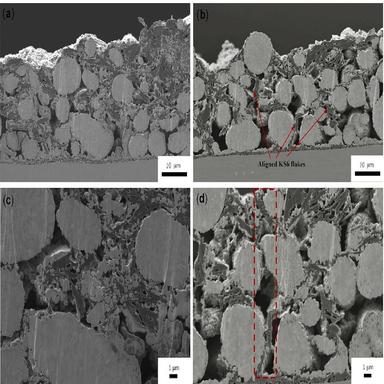
Cross-sectional SEM images at two magnifications of reference (left) and aligned (right) electrodes.